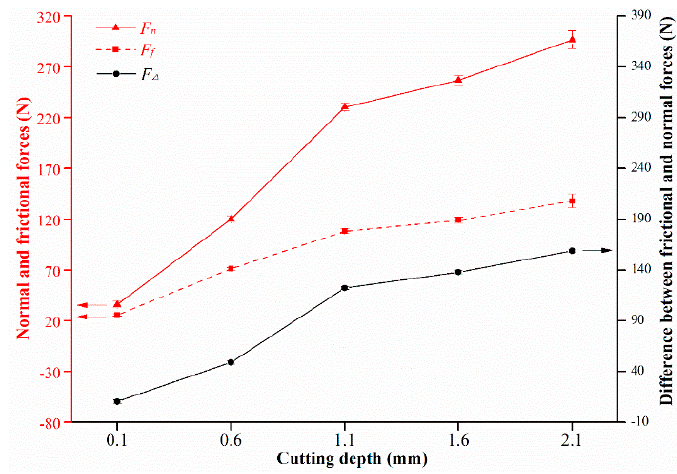
Figure 5. Influence of cutting depth on cutting forces; each point is the average of five observations, and the error bars of each data point represent one standard deviation.